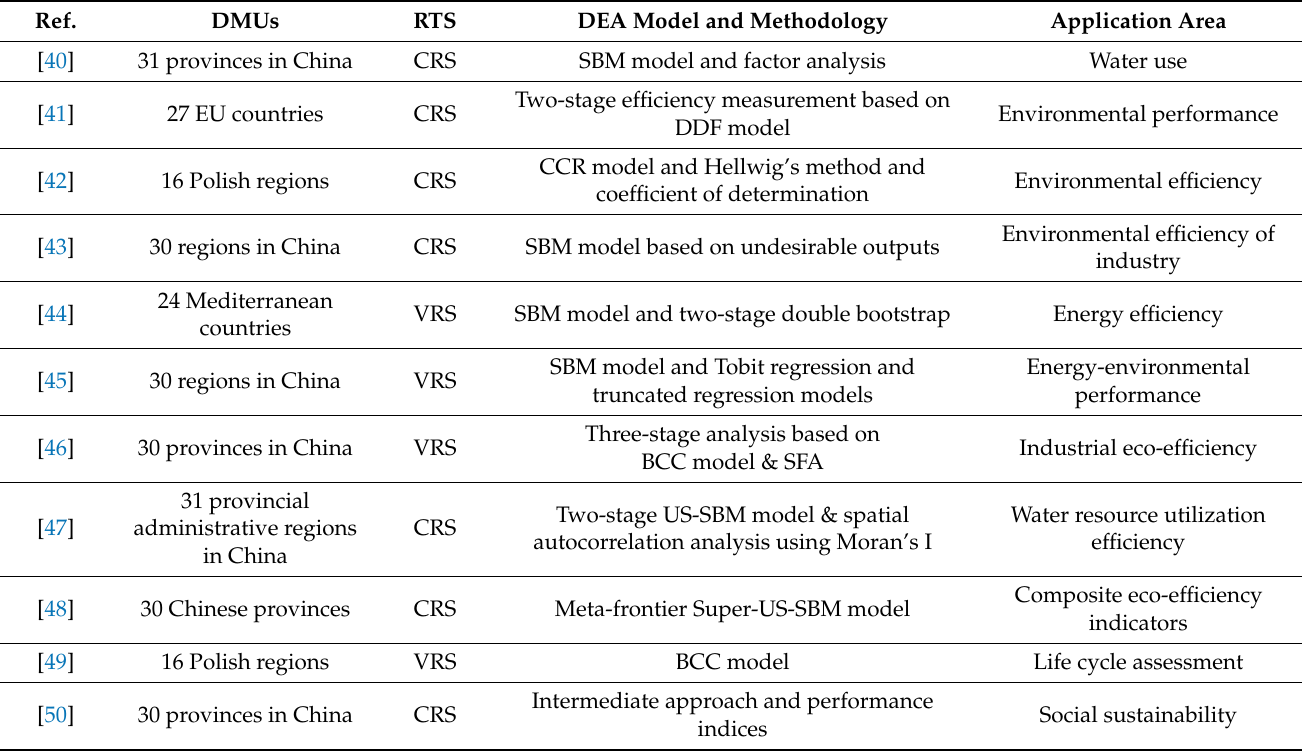
Table 1. Summary of the recent literature on environmental efficiency evaluation of regions using DEA.